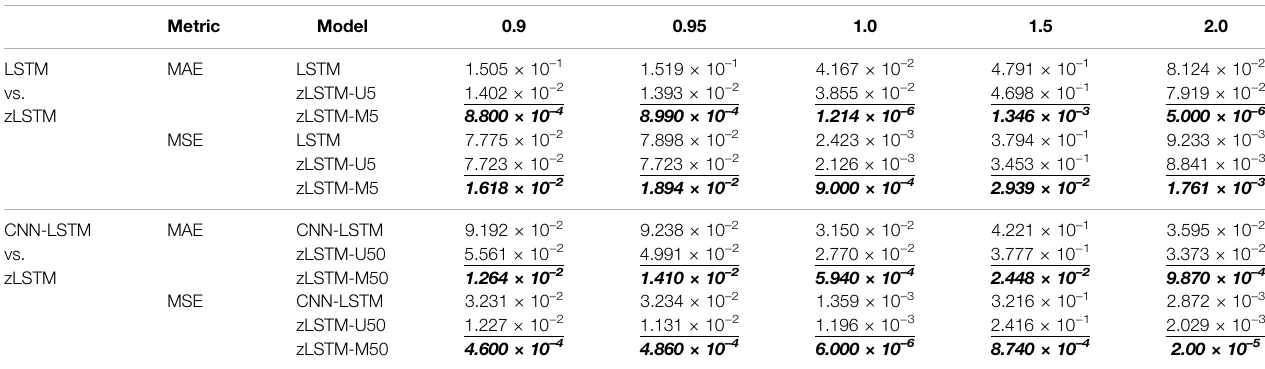
TABLE 3 | Prediction accuracy evaluations for pressurizer water